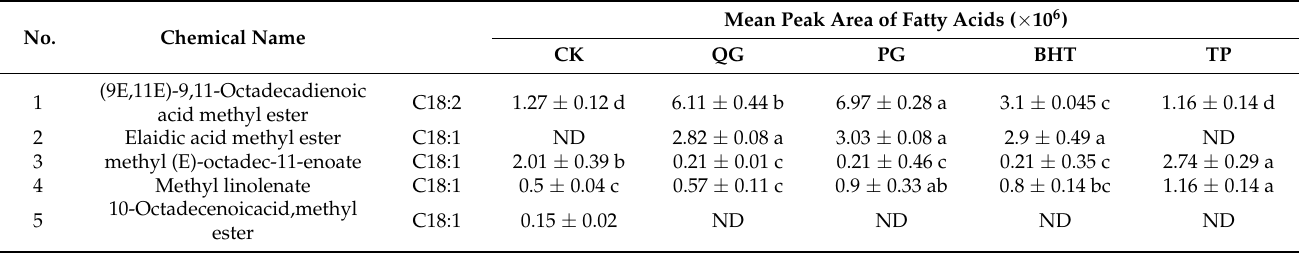
Figure 4. Fatty acid composition of oil treated with different antioxidants: PCA score plot ( a ); PLS-DA score plot ( b ); mean peak area of saturated fatty acids (SFAs) and unsaturated fatty acids (UFAs) ( c ); mean peak area of various unsaturated fatty acid ( d ). Table 3. Individual fatty acid composition in soybean oil (mean ± SD,